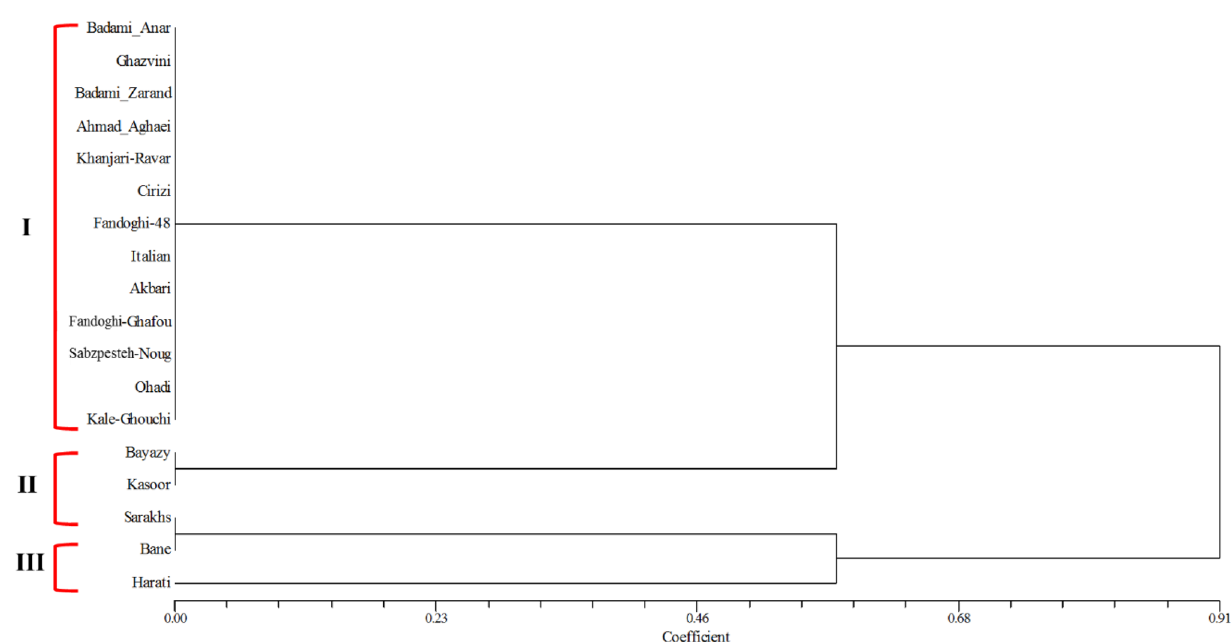
Figure 10. Dendrogram of UPGMA cluster analysis of 16 P. vera genotypes and two species of Pistacia genus based on the mir171g + mir393e, mir172b + mir166k, and ISSR-PvC + mir399a markers data. The dendrogram was constructed from the Jaccard’s similarity coefficients matrix through the NTSYSpc v2.02e software (https:// ntsys pc. softw are. infor mer.